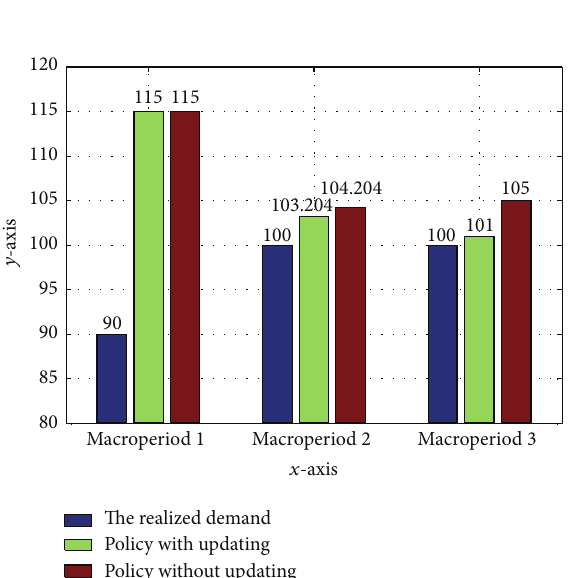
Figure 2: Comparison for the total operating cost with and without consideration of demand uncertainty. Figure 3: Comparison for the realized demand and the actual production for crude mix under three